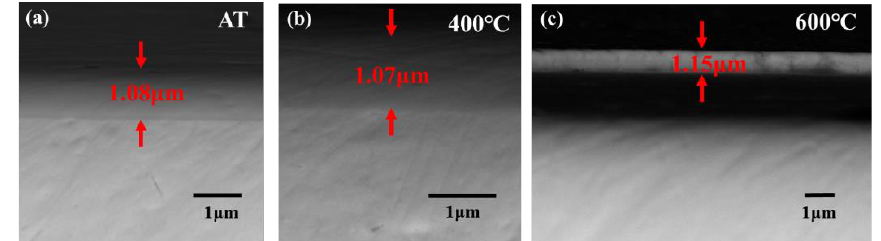
Figure 7. The SEM photographs of the Ta-Hf-C coatings under different deposition temperatures ( a ) Ambient temperature ( b ) 400 °C and ( c ) 600 °C.